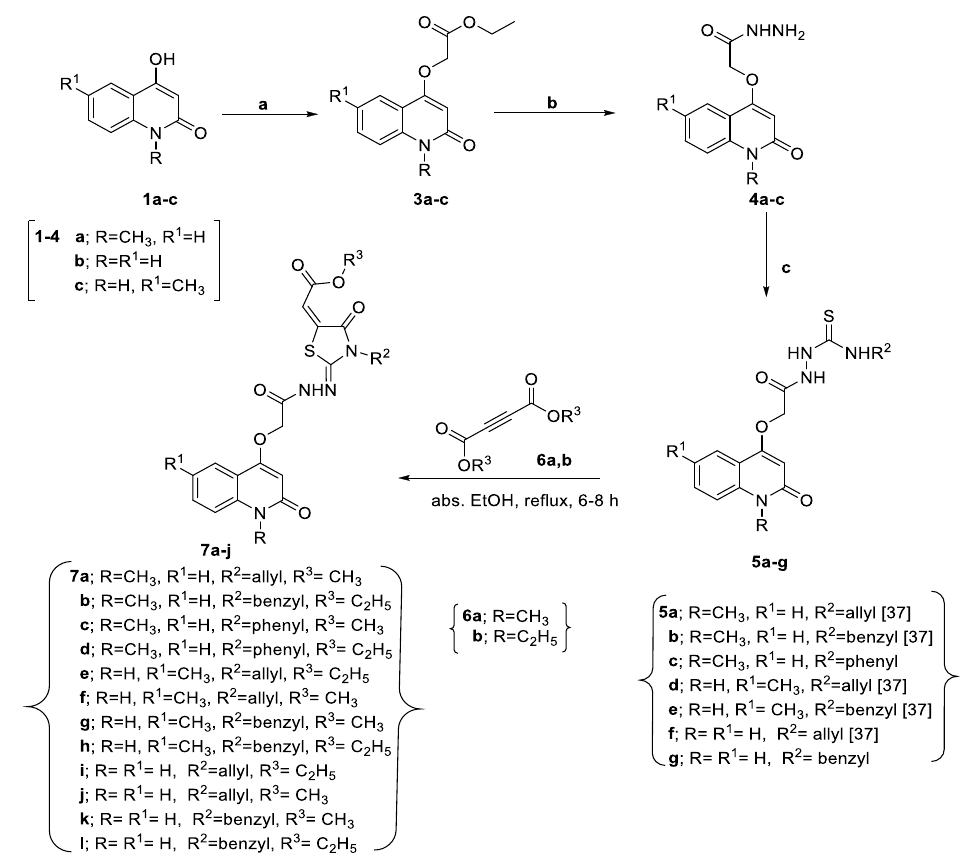
Scheme 1. Synthesis of 4-oxothiazolidinquinolone 7a – l . Reagents and Conditions: ( a ) ethyl bromo-